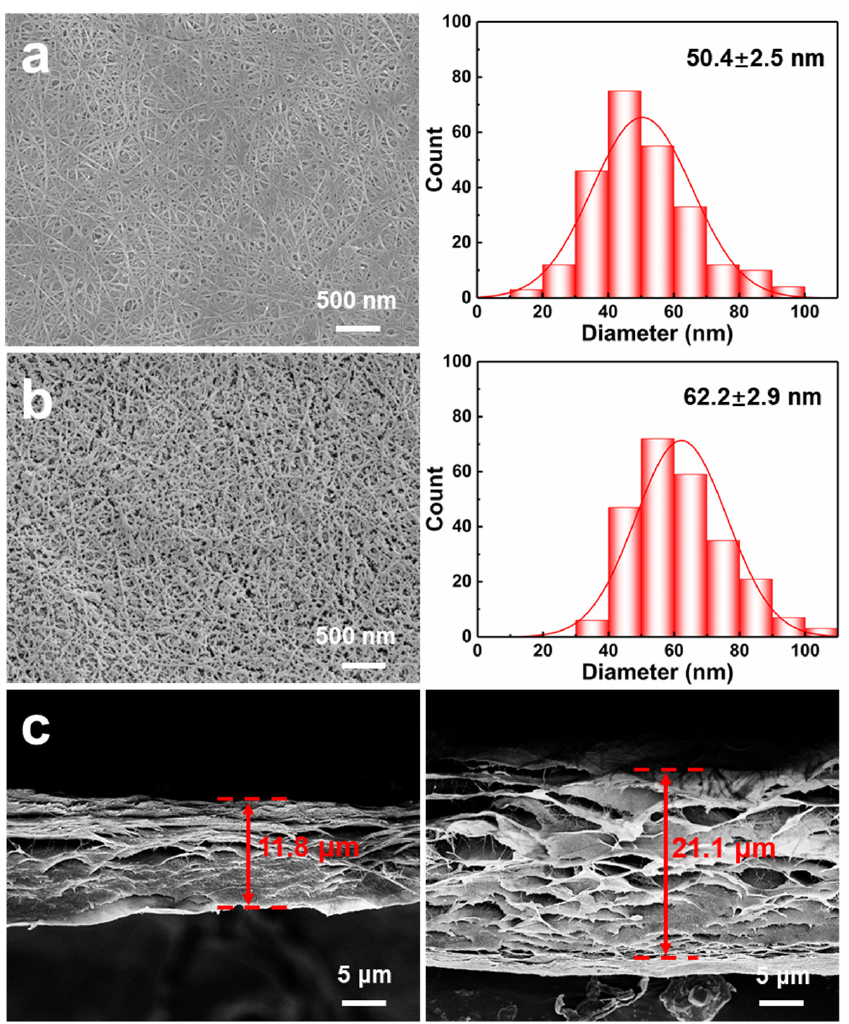
Figure 2. SEM images of surface (left) and pore size distribution (right) of ( a ) TCNF membrane and ( b ) THPC@TCNF membrane. ( c ) SEM images of cross-section of TCNF membrane (left) and THPC@TCNF membrane (right).